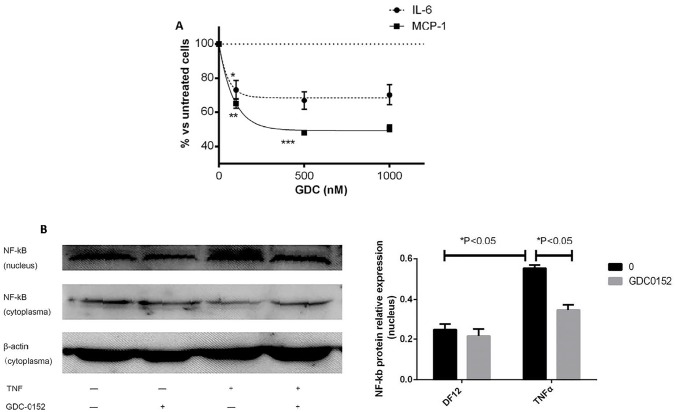
Inhibitor of Apoptosis Proteins (IAPs) were involved in MCP-1/IL-6 production under high dose TNF-α stimulation.A. hUC-MSCs (2x104 in 96-well plates) were pretreated for 2h with the IAP inhibitor GDC-0152 at increasing concentrations (0–1000 nM), then stimulated with TNF-α (20 ng/ml, 1.2 nM). After a further 24h, trypan blue was used to exclude cell toxicity. SN was collected and IL-6 and MCP-1 concentrations were measured by ELISA. B. hUC-MSCs(5×105 in T25 bottle) were pretreated with GDC-0152(1000nM) for 2 h, then stimulated with TNF-α (20 ng/ml, 1.2 nM). 24 hours later, protein from nucleus and cytoplasma were extracted separately and the amount of NF-kB were detected by Western blot. Data are as mean±SEM of triplicate measurements; *p<0.05, **p<0.01, ***p<0.001 when compared to untreated cells. These experiments were repeated 3 times with the same results, using clone 69 and another TNF-α sensitive clone (clone 120003).